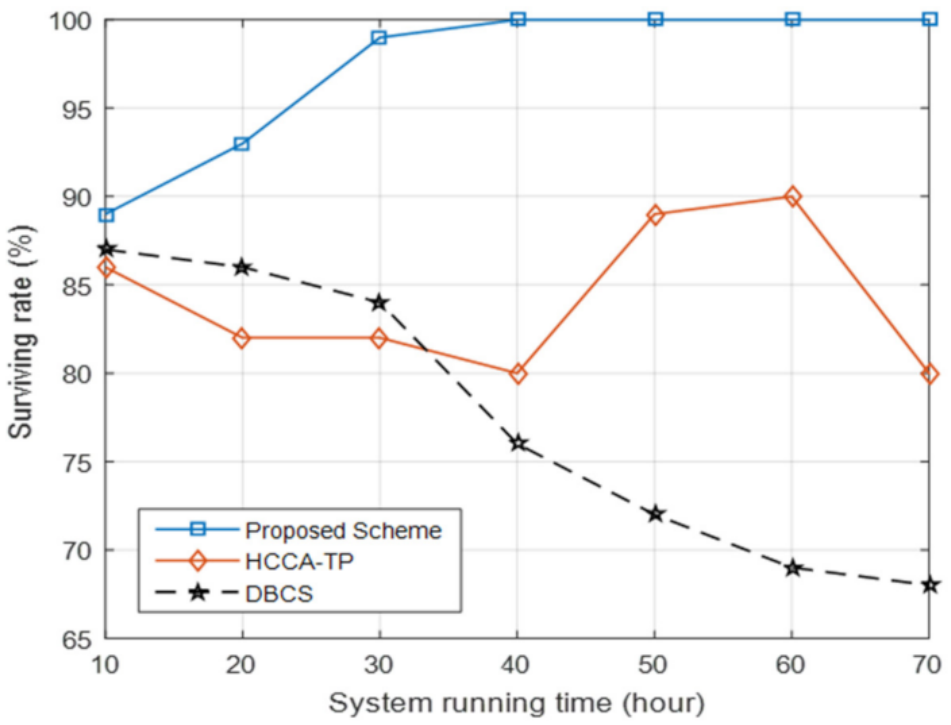
Figure 2. Survival rates of sensor nodes in the